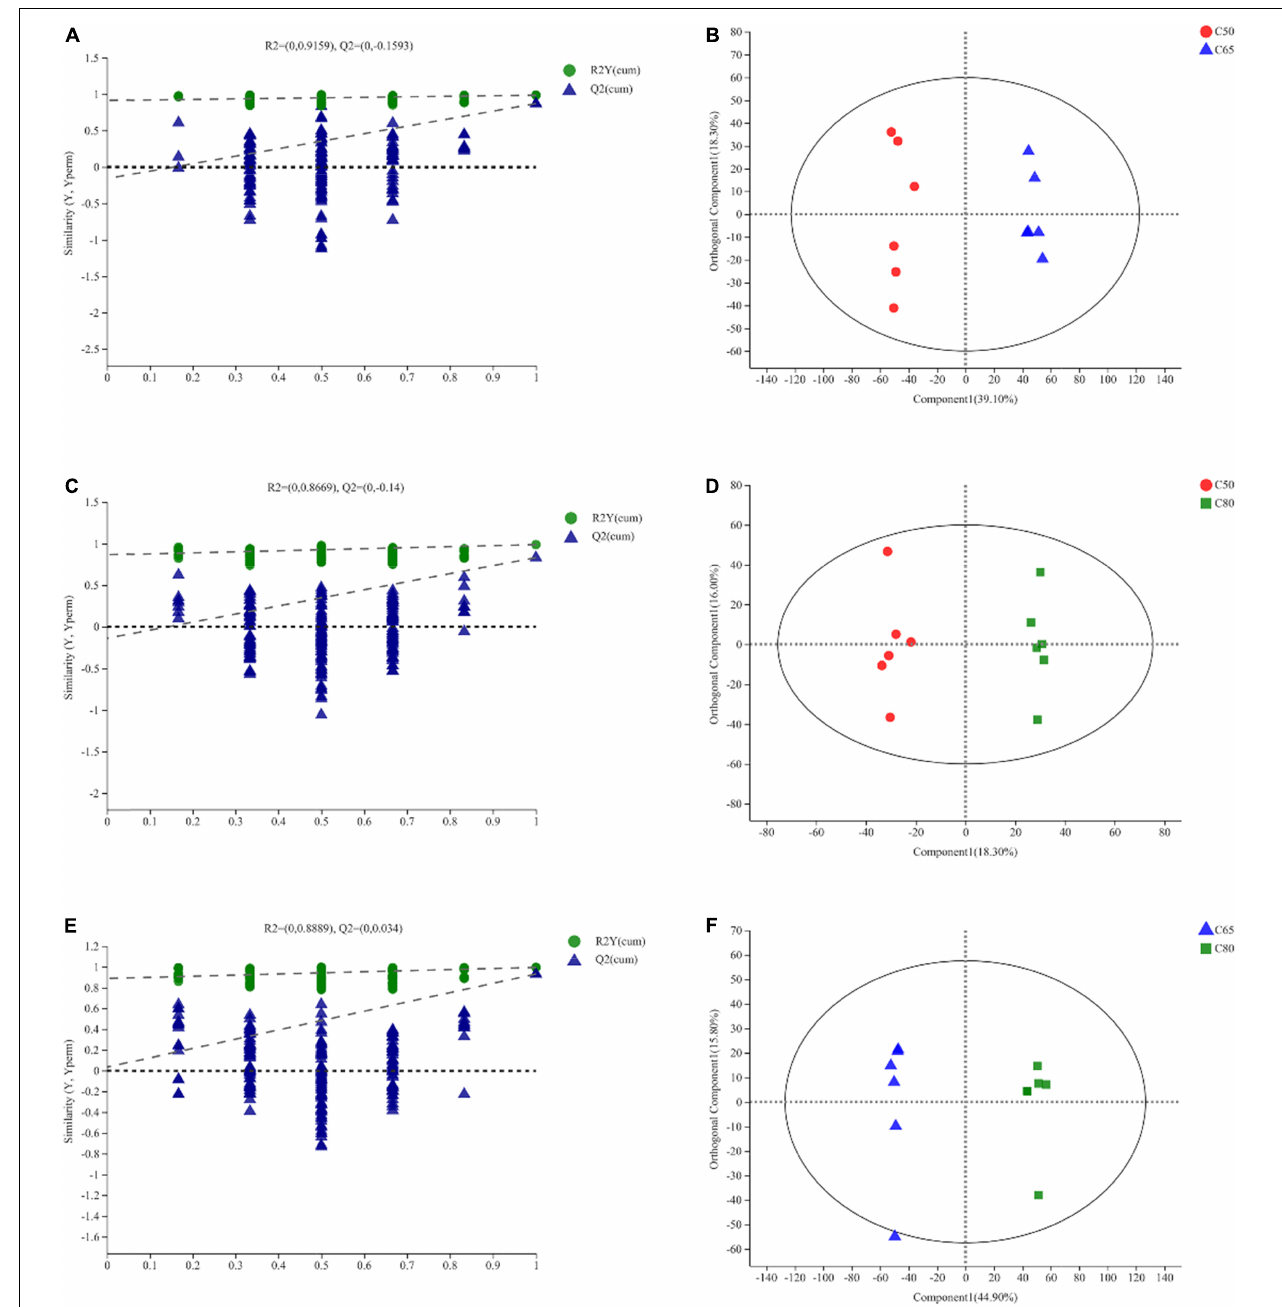
FIGURE 4 | Orthogonal partial least squares discriminant analysis (OPLS-DA) of yak rumen metabolites. OPLS-DA permutation test. The abscissa represents the permutation retention of the permutation test. The ordinate represents the value of the R2 (green circle) and Q2 (blue triangle) permutation tests. The two dashed lines represent the regression lines of R2 and Q2, respectively (A,C,E) . The OPLS-DA score map, through orthogonal rotation, filters out information irrelevant to the group, so that the difference between the groups can be better distinguished and the performance of the model can be improved. The abscissa represents the degree of interpretation of the first predicted principal component. The ordinate represents the degree of interpretation of the first orthogonal component (B,D,F) . C50, dietary concentrate-to-forage ratio 50:50; C65, dietary concentrate-to-forage ratio 65:35; C80, dietary concentrate-to-forage ratio